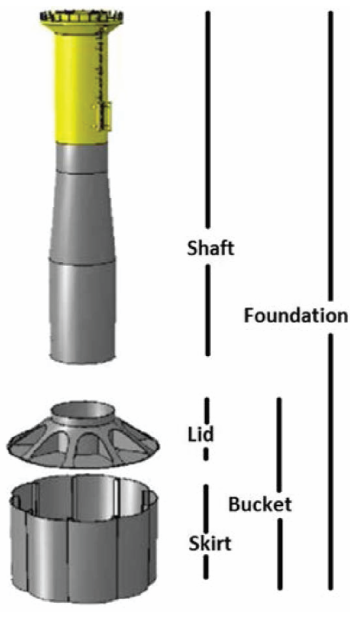
Figure 1. Mono Bucket